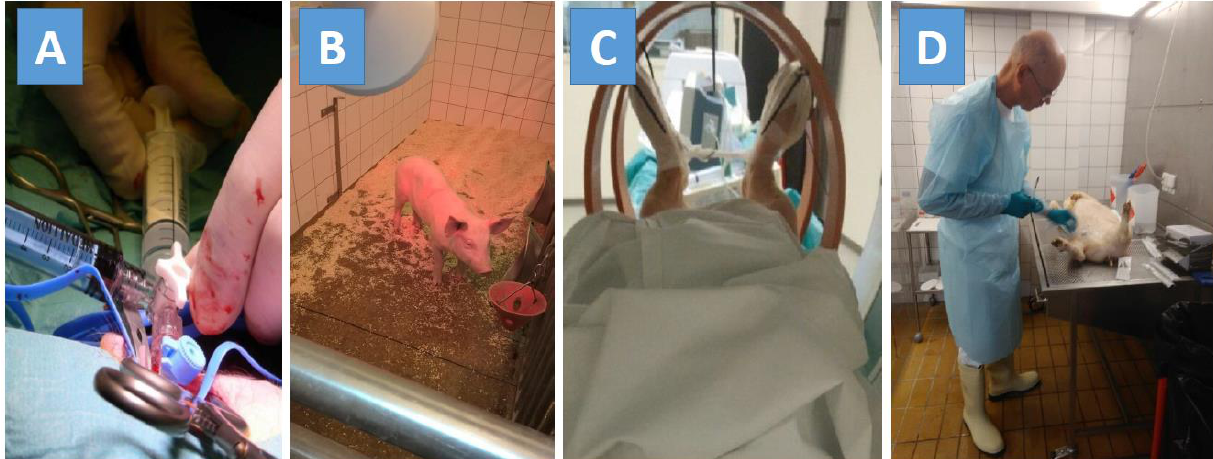
Figure 1. Step-by-step procedures for haematogenously induced osteomyelitis in a pig model used for comparing new tracers with known tracers: ( A ) Inoculation with a porcine isolate of Staphylococcus aureus in the right femoral artery of anesthetized 20 kg domestic pigs. ( B ) For the next seven days, the pigs were treated with painkillers and their clinical signs were scored every eight hours. If signs of bacteria spread to internal organs (cough, severe fever, tachycardia, anorexia, or inactivity) and thus septicaemia was observed, the pig was euthanized as a result of the pre-set humane endpoints. ( C ) After six days the pigs were CT scanned for verification of visible osteomyelitis, and the next day (day seven after inoculation) the pigs were exposed to the PET scanning program with several known and new osteomyelitis tracers. Both dynamic and static scans were performed, and blood samples from the carotid artery were collected and used to establish blood–activity curves and metabolite analyses. ( D ) At the end of the scans, the pigs were euthanized during the anaesthesia with an overdose of pentobarbital, after which a regular necropsy of the pigs was performed. This was guided by the findings from the CT scans the day before. The necropsy was performed to disclose the location and character of the various induced lesions so that the effectiveness of the tested tracers could be evaluated relative to the necropsy findings. Bacteria from lesions were cultured to determine if they originated from the inoculated bacteria strain.